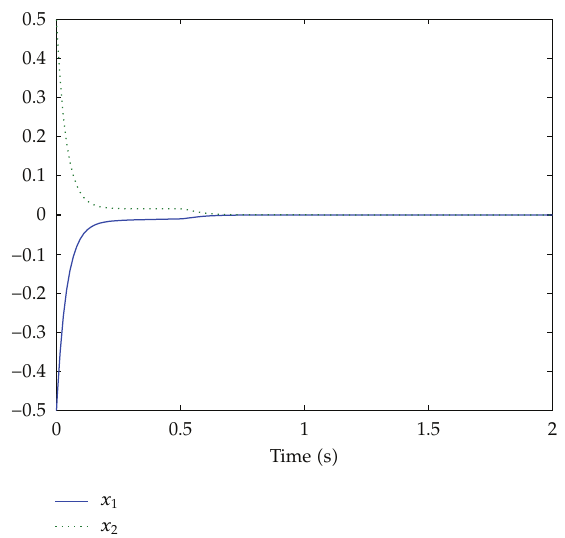
Figure 1: The state x 1 and x 2 of the closed-loop system in Example